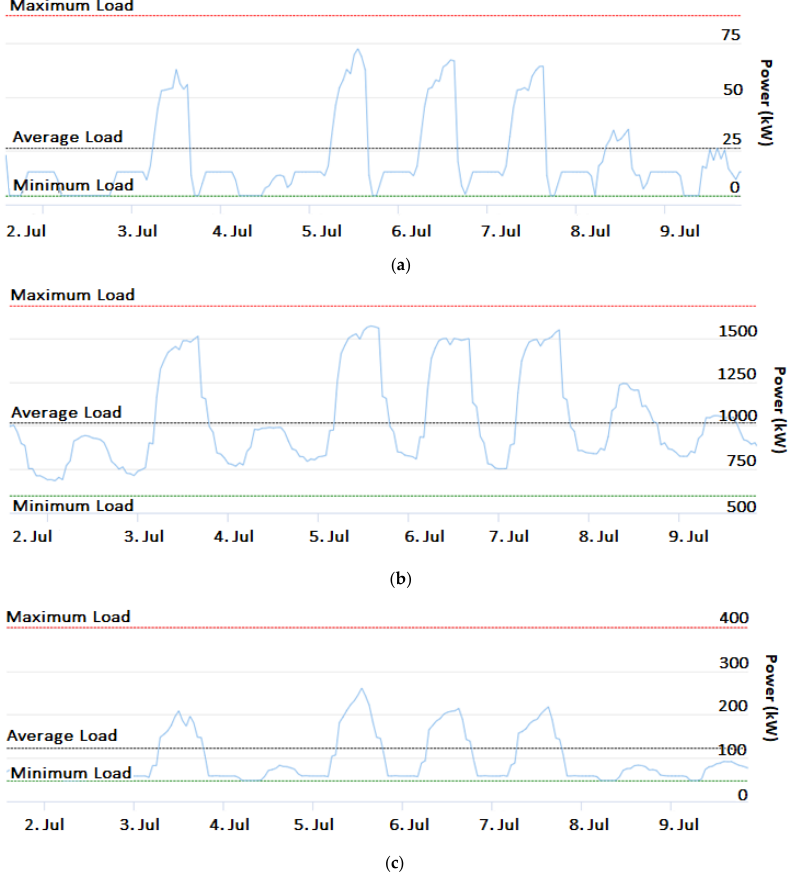
Figure 2. Weekly load profiles: ( a ) warehouse, ( b ) hospital, and ( c ) primary school.